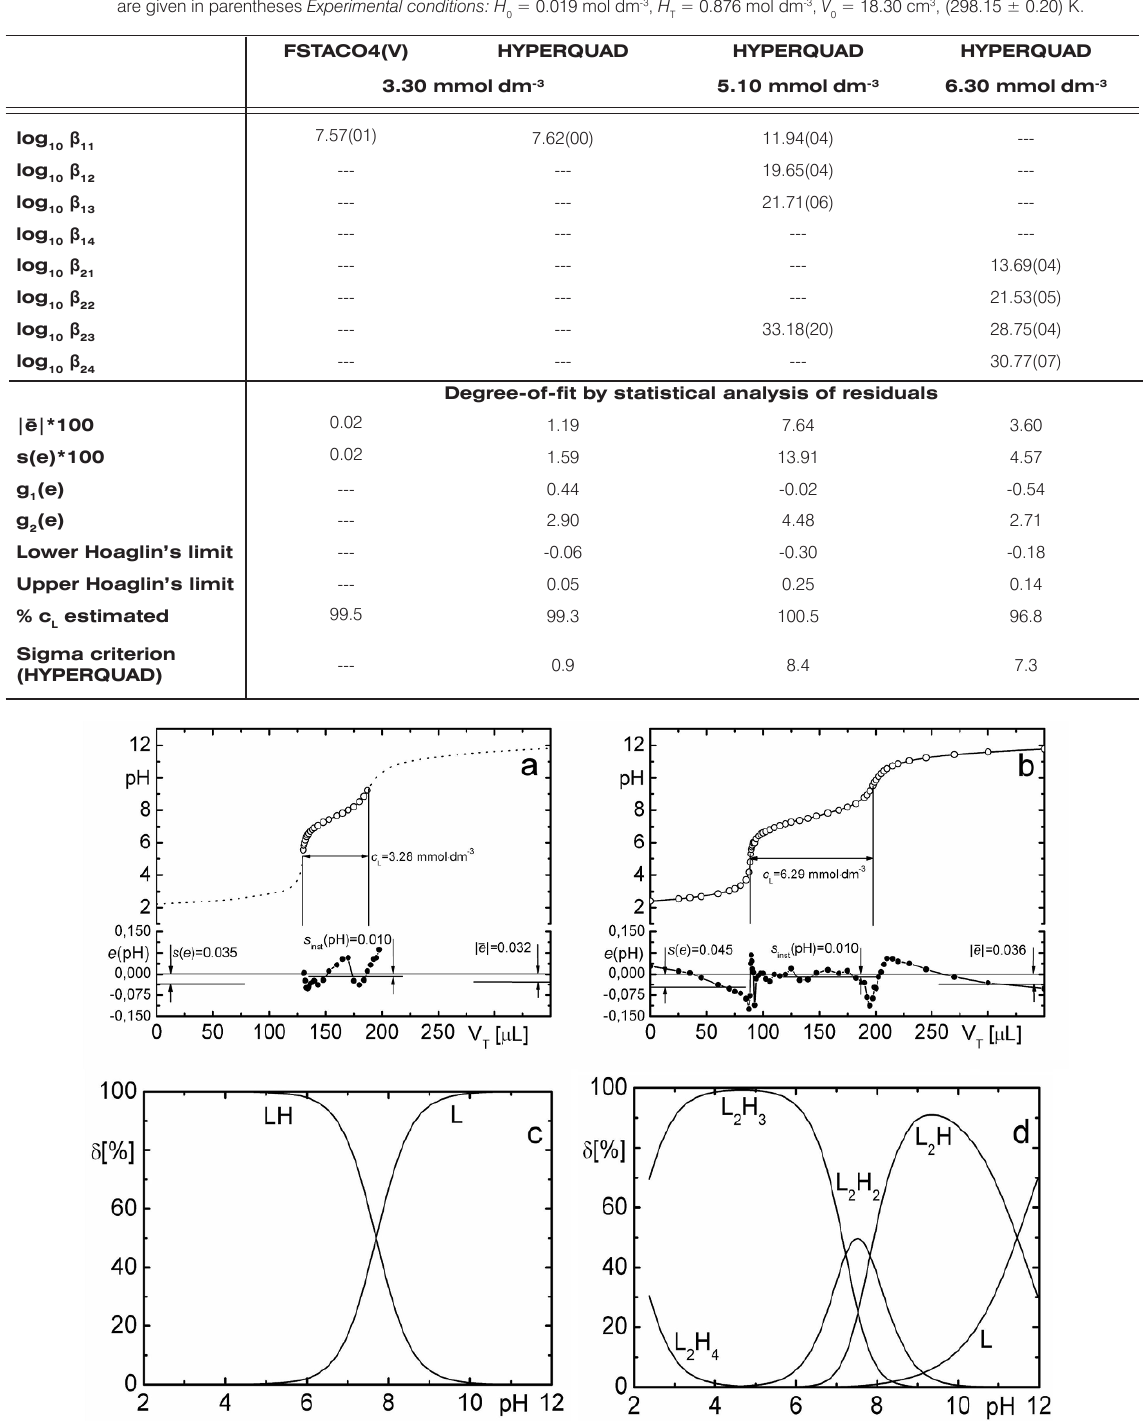
Figure 4. Potentiometric titration curve of vildagliptin for two different concentrations of titrand, c c = 6.3 mmol dm -3 when dimers prevail (b) when titrant is 0.876 mol dm -3 KOH. The titration curve is in original ( V L its interpretation using distribution diagrams of the relative population of all variously protonated species was calculated for monomers (c), and for dimers (d). The resolution criteria in goodness-of-fit analysis s chemical model using HYPERQUAD are in the lower parts of each figure. Experimental conditions : T = 298.16 K, I =